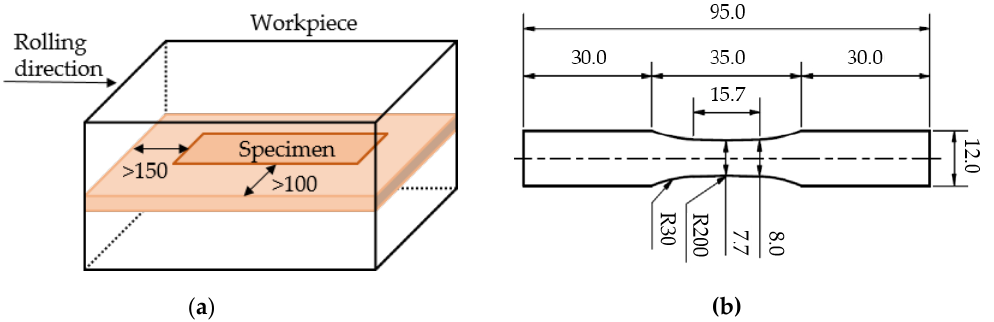
Figure 1. Specimen geometry for fatigue tests and micromagnetic investigations (in mm): ( a ) area for specimen extraction with respect to the rolling direction (RD); ( b ) geometry and dimensions adapted from [30].